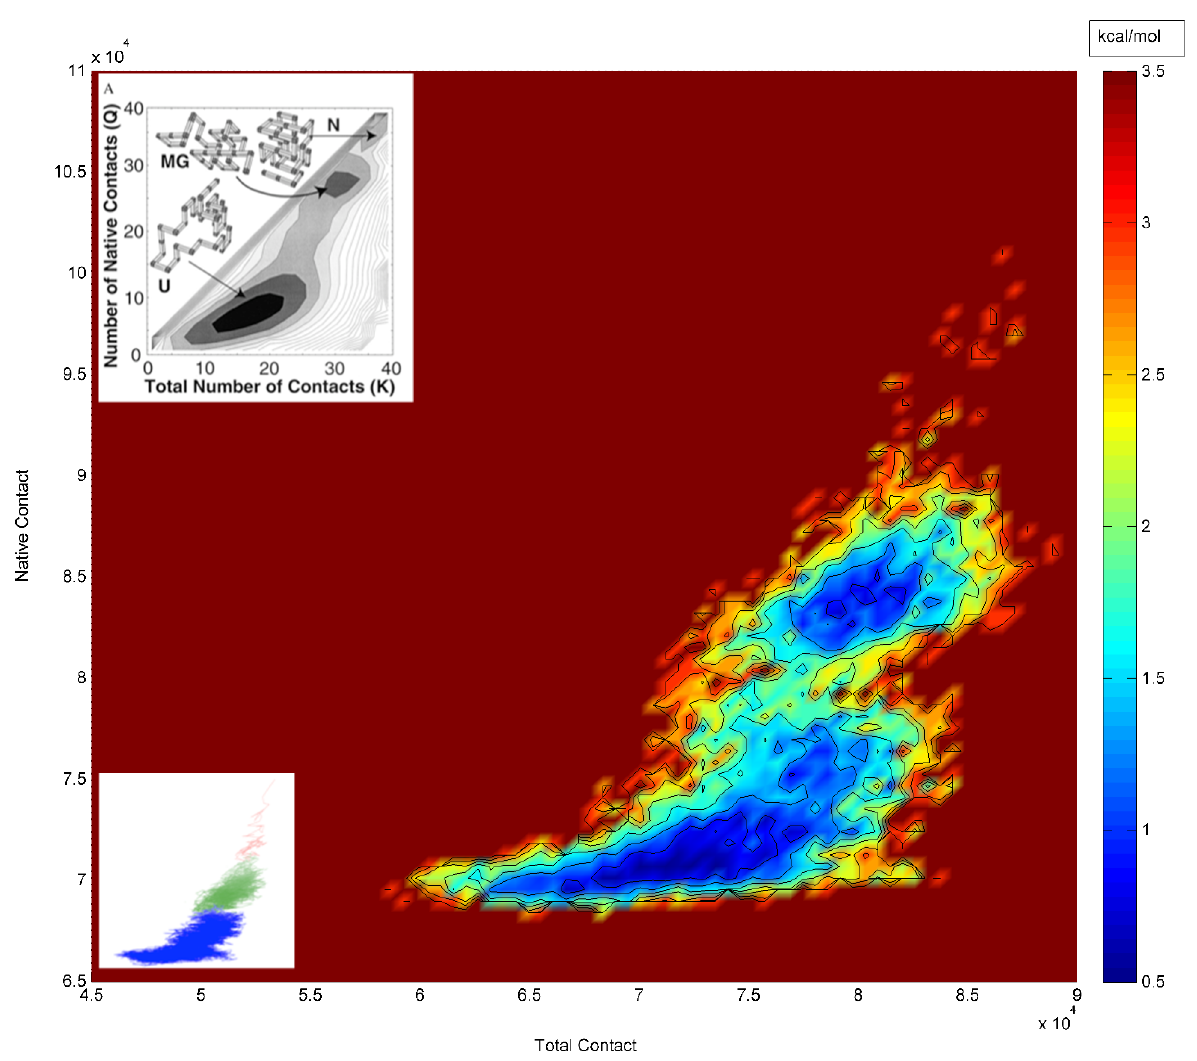
Figure 10. Evolution of secondary structure in the MDUF trajectory #1 of U1A. Key: Yellow: β -sheets. Red: α -helices. This plot was obtained using VMD [68]. Top left insert: Corresponding lattice model results from Pande and Rokhsar [70].